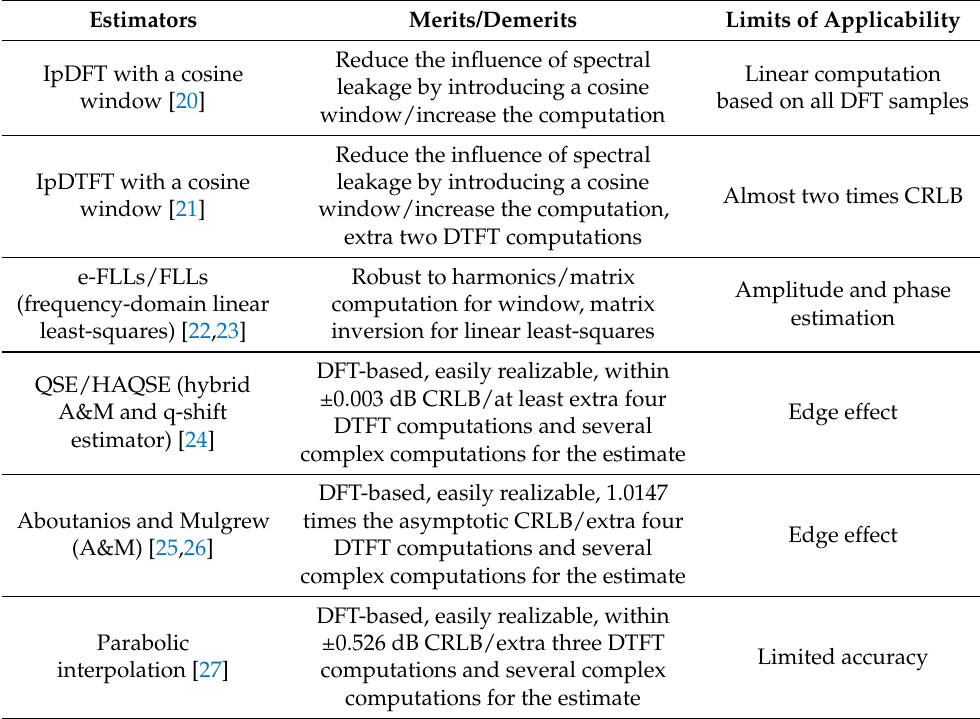
Table 1. Analysis of key